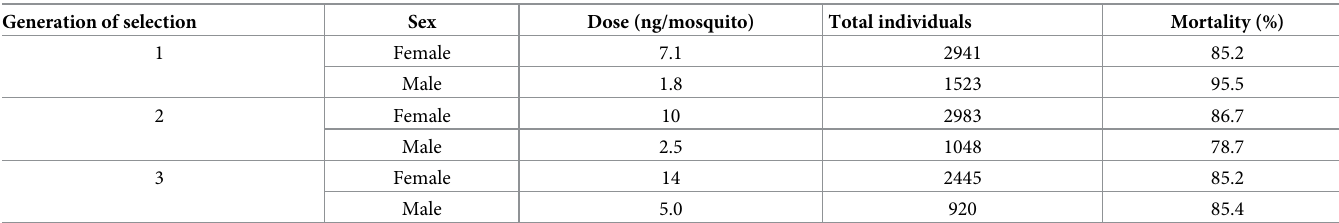
Table 1. Cyhalothrin selection of the LM